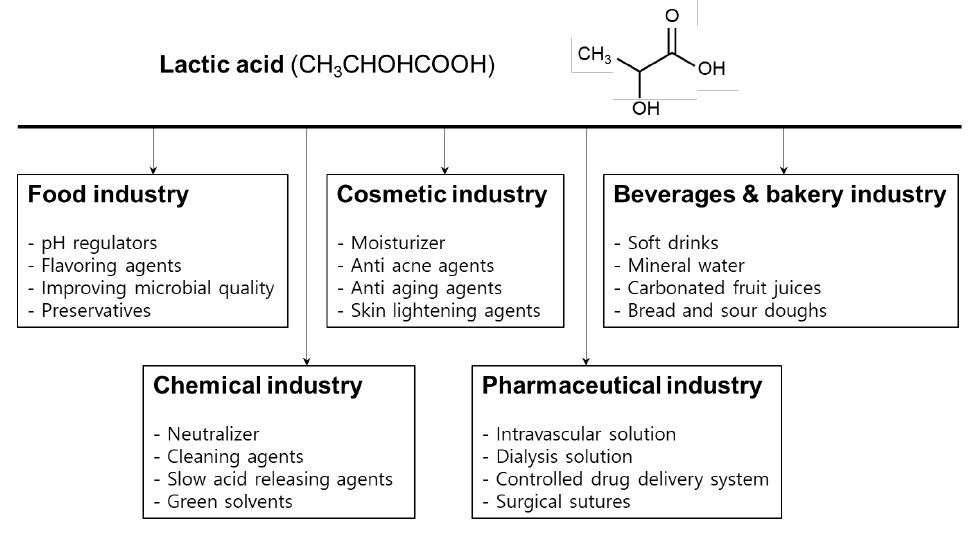
Figure 2. Prospective applications of lactic acid in different industries.